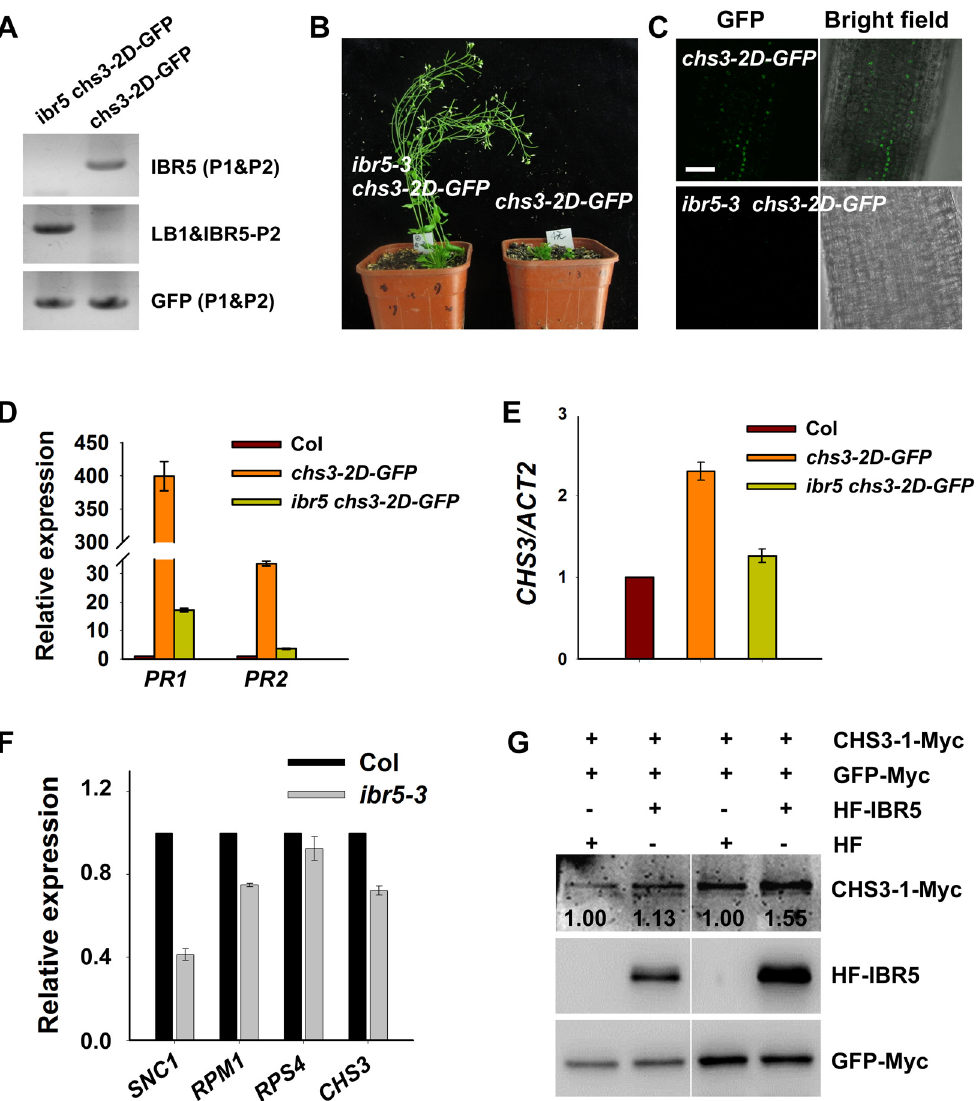
Fig 4. CHS3 is promoted by IBR5 at both mRNA and protein levels. Genotyping of ibr5-3 chs3-2D-GFP plants. The primers used for genotyping the chs3-2D-GFP gene were GFP-P1 and GFP-P2, and the primers used for genotyping ibr5-3 were IBR5-P1, IBR5-P2 and LB1 as listed in S1 Table. The phenotype of chs3-2D-GFP transgenic plants was rescued by ibr5-3 . chs3-2D-GFP and ibr5-3 chs3-2D-GFP plants were grown for 5 weeks, and representative plants are shown. Expression of CHS3-2D-GFP protein in 8-d-old chs3-2D-GFP and ibr5-3 chs3-2D-GFP plants. Bar: 100 μ m. (D, E) Expression of the PR1 , PR2 (D) and CHS3 (E) genes in chs3-2D-GFP and ibr5-3 chs3-2D-GFP plants. The values were normalized to the expression of ACTIN2 . The error bars represent the SD of three replicates. (F) The expression of several R genes ( SNC1 , RPM1 , RPS4 and CHS3 ) in 10-day-old ibr5-3 mutant grown at 22°C. The values were normalized to the expression of ACTIN2 . The error bars represent the SD of three replicates. Similar results were obtained in three independent experiments. (G) The effect of IBR5 on the CHS3 protein level in Arabidopsis protoplasts. Super : CHS3-1-Myc and 35S : HF-IBR5 or 35S : HF constructs were co-expressed in Arabidopsis protoplasts. IBR5 and CHS3 proteins were detected using anti-HA and anti-Myc antibodies. The GFP-Myc construct was used as a control for transformation efficiency. The numbers show the ratios of CHS3-1-Myc to GFP-Myc protein levels. Two biological repeats are shown with similar results.